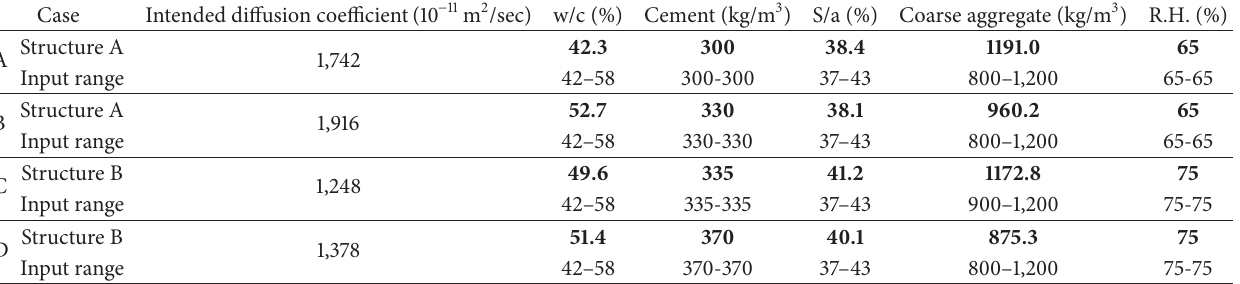
Table 9: Mixture design through proposed GA